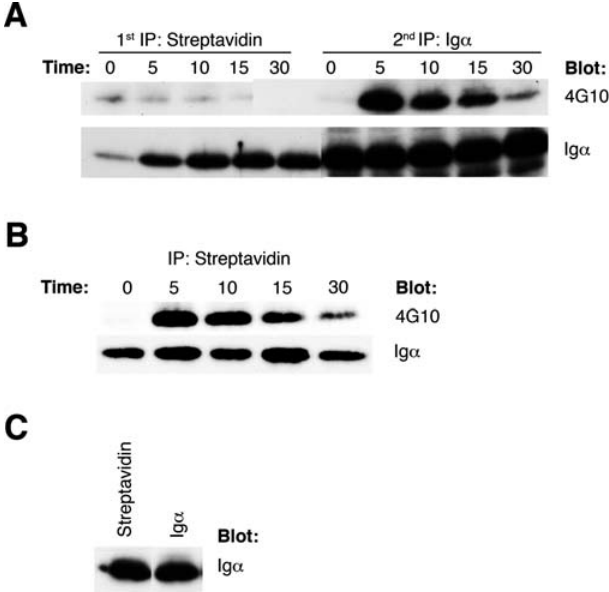
Figure 2. Following BCR Stimulation, Phosphorylated Ig a Is Retained on the Cell Surface (A) A20IIA1.6 cells were surface-biotinylated with Sulfo-NHS-SS-Biotin on ice, stimulated with anti-IgG for the indicated times (min) and then biotin was stripped from the cell surface. Lysed samples were precipitated sequentially with streptavidin and then anti-Ig a antibodies. Parallel samples were then immunoblotted with anti-phosphotyrosine (4G10) or anti-Ig a antibodies. (B) Cells were labeled and stimulated as above except that biotin was not stripped from the cell surface. Streptavidin precipitations were then sequentially immunoblotted with 4G10 and anti-Ig a antibodies. (C) Resting surface-biotinylated cells were directly lysed and sequentially precipitated with streptavidin and then anti-Ig a antibodies. Precipita- tions were Western blotted with anti-Ig a antibodies. DOI: